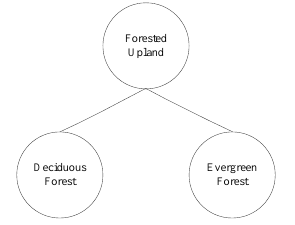
Figure 3 Representation of Running